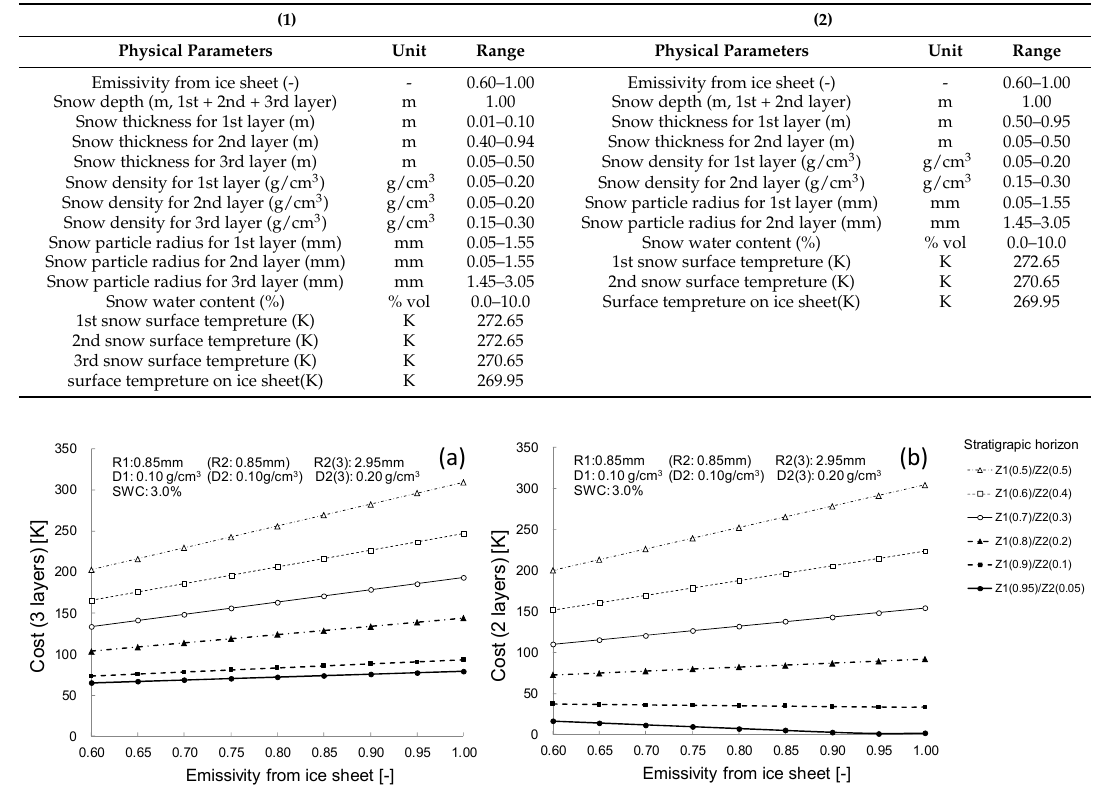
Figure 3. Comparison of the cost of ( a ) the three-snow-layer models (Cost 3 layer): Average of 1st layer 0.01, 0.03, 0.05, 0.08, and 0.10 m) and ( b ) the two-snow-layer models (Cost 2 layer), associated with variation in emissivity from the ice sheet at the QH3 site. The vertical axis shows cost. The horizontal axis gives the assumed emissivity from the ice sheet (0.60, 0.65, 0.70, 0.75, 0.80, 0.85, 0.90, 0.95, and 1.00). Snow structure reflects the six cases described in the text, having upper layer (Z1)/bottom layer (Z2) values of 0.5/0.5 m, 0.6/0.4 m, 0.7/0.3 m, 0.8/0.2 m, 0.9/0.1 m and 0.95/0.05 m). Other values were set, as follows: snow particle radius (upper layer: R1 = 0.85 mm; and bottom layer: R2 = 2.95 mm), snow density (upper layer: 0.10 g/cm 3 ; and bottom layer: 0.25 g/cm 3 ), and snow water content (SWC = 3 vol %).